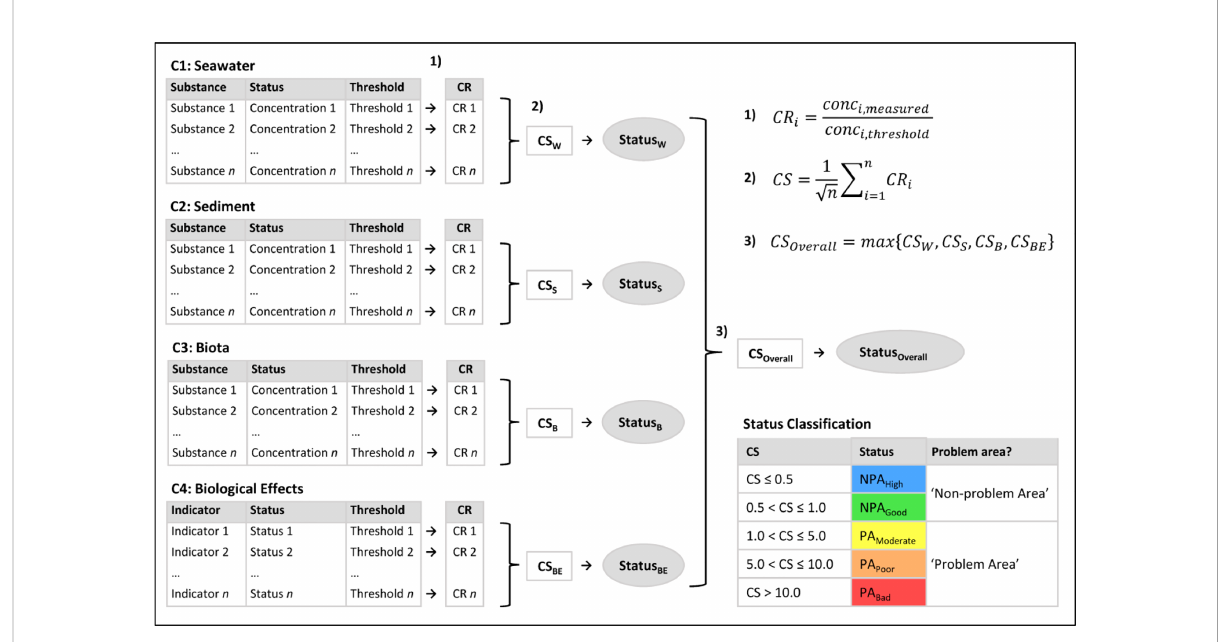
FIGURE 1 Sketch of the CHASE method. Indicators are grouped in four categories: C1: concentrations in water, C2: concentrations in sediment, C3: concentrations in biota and C4: biological effects. A Contamination Ratio (CR) is calculated for each indicator/substance (Equation 1). For categories 1, 2 and 3, the Contamination Score (CS) is calculated (Equation 2). The CS determines the status for each category, according to the table “ Status Classi fi cation ” . The integrated CS is determined as the maximum score for all categories (Equation 3), and thereby the integrated CHASE classi fi cation of the overall status within an assessment unit is given by the ‘ one out-all out ’ principle. Please note, that for biological effects (C4), CHASE calculates a mean Contamination Ratio rather than using Equation